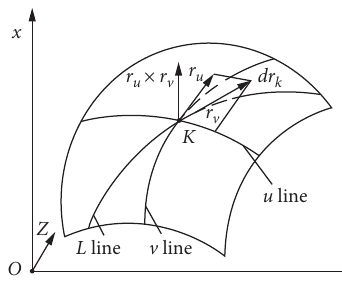
F IGURE 10: The guide vector of the